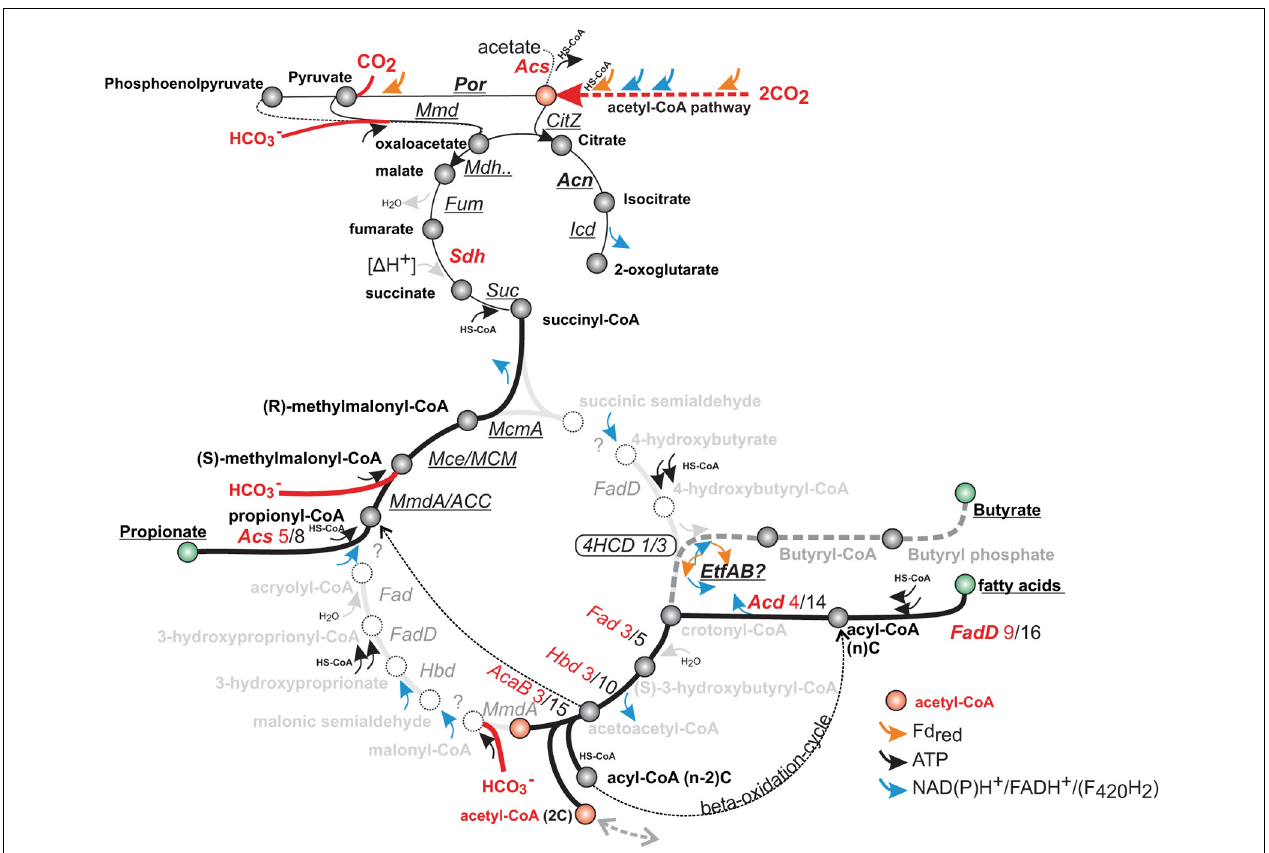
FIGURE 7 | Genes corresponding to fatty acid and propionate metabolism, compared with putative steps in the 4-hydroxybutyryl (4HB) and 3-hydroxyproprionyl (3HP) pathway of autotrophic Creanarchaea. Homologousgenescorrespondtoseveralstepsinthe4HCDand3HPpathway (intermediatenamesingray),andmaynotbeeasily-distinguishedbyhomology